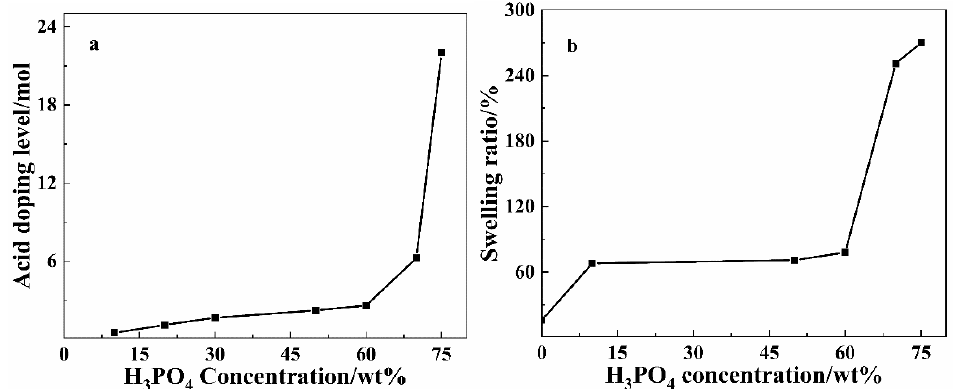
Figure 3. ( a ) Doping level; ( b )Swelling ratio of phosphoric acid doped PPI as a function of the H 3 PO 4 concentration.